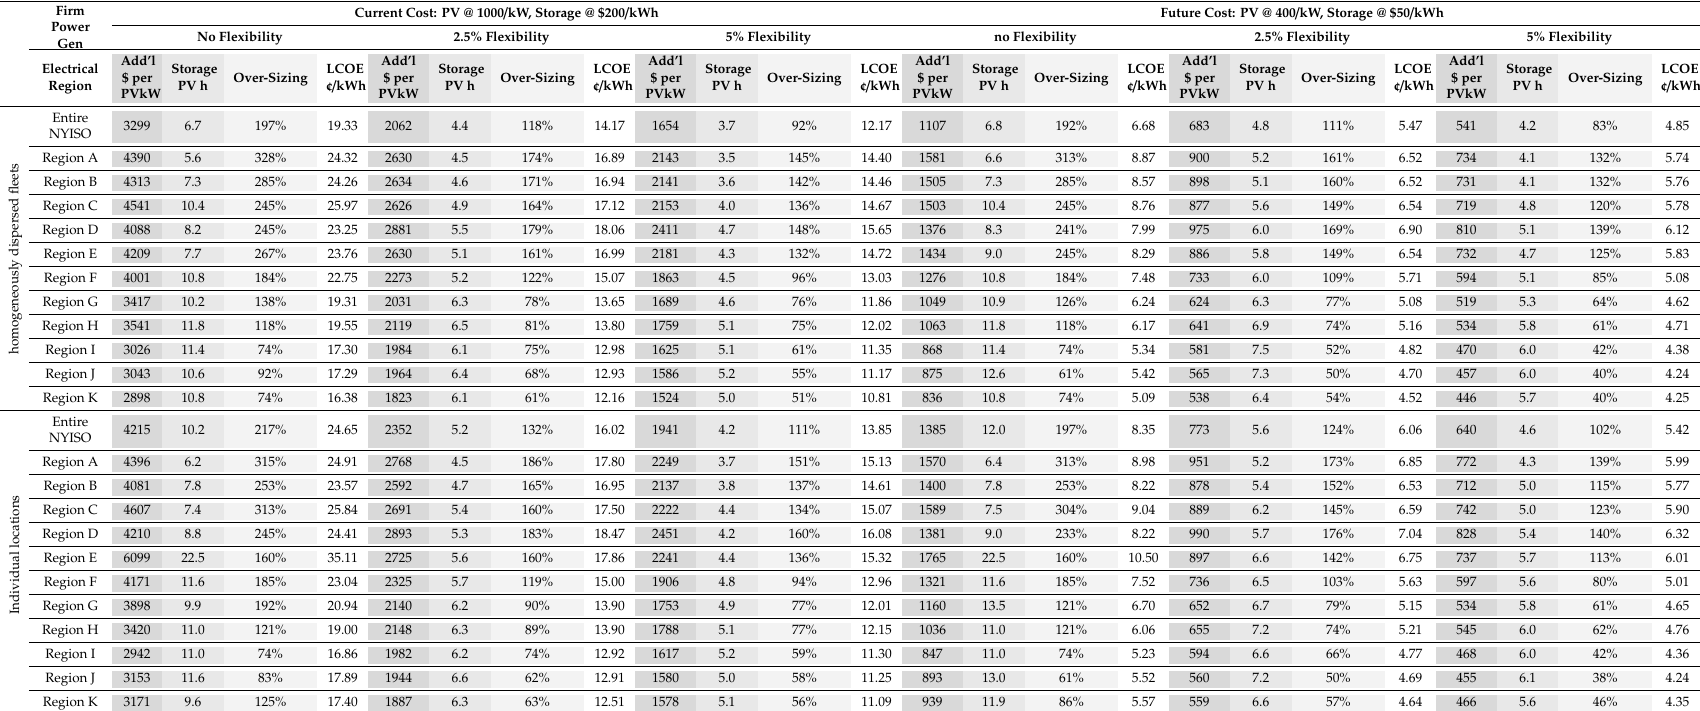
Table 4. Firm power generation with implicit